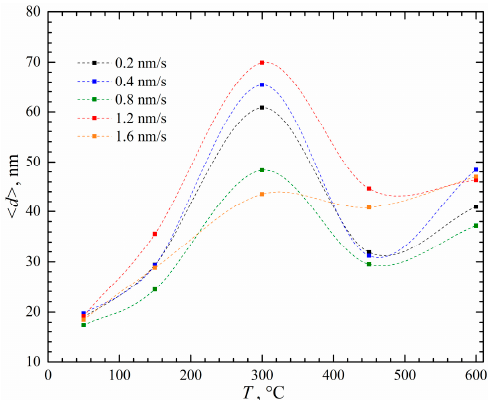
Figure 5. Crystallite size dependence on substrate temperature of ScSZAl thin films deposited on Alloy 600 substrates using different deposition rates.